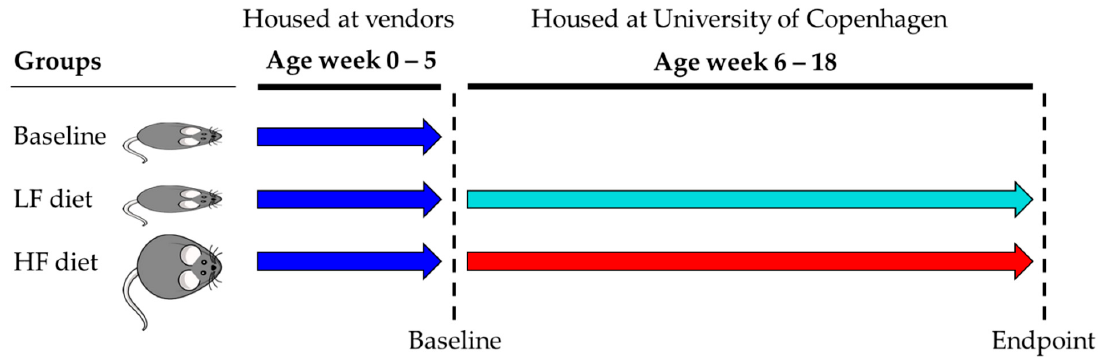
Figure 1. C57BL/6N mice were purchased from three different vendors: Taconic ( n = 18), Charles River ( n = 18), and Janvier ( n = 18) and each vendor were divided into baseline, low-fat (LF) diet, and high-fat (HF) diet groups. The baseline mice ( n = 6 pr. vendor) were sacrificed at arrival (age week five) and the LF and HF diet groups ( n = 12 pr. vendor) were fed for 13 weeks before being sacrificed at endpoint (age week 18). Blue arrow = baseline, cyan arrow = LF diet, red arrow = HF diet.